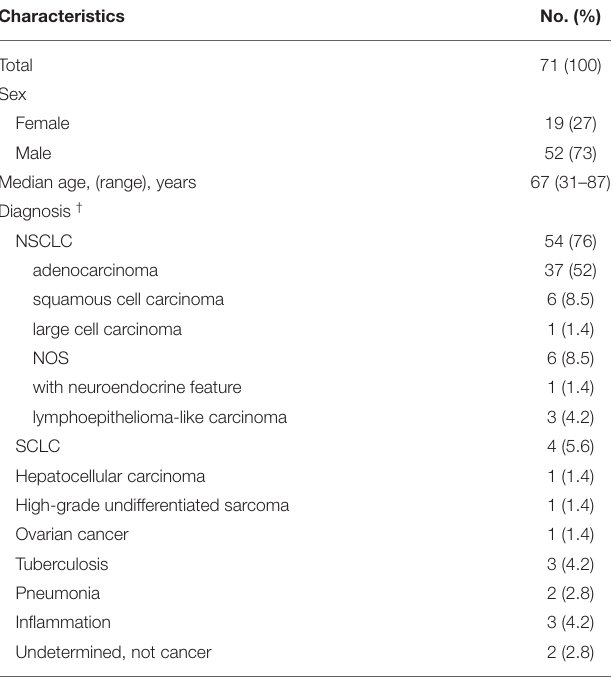
TABLE 1 | Baseline patient